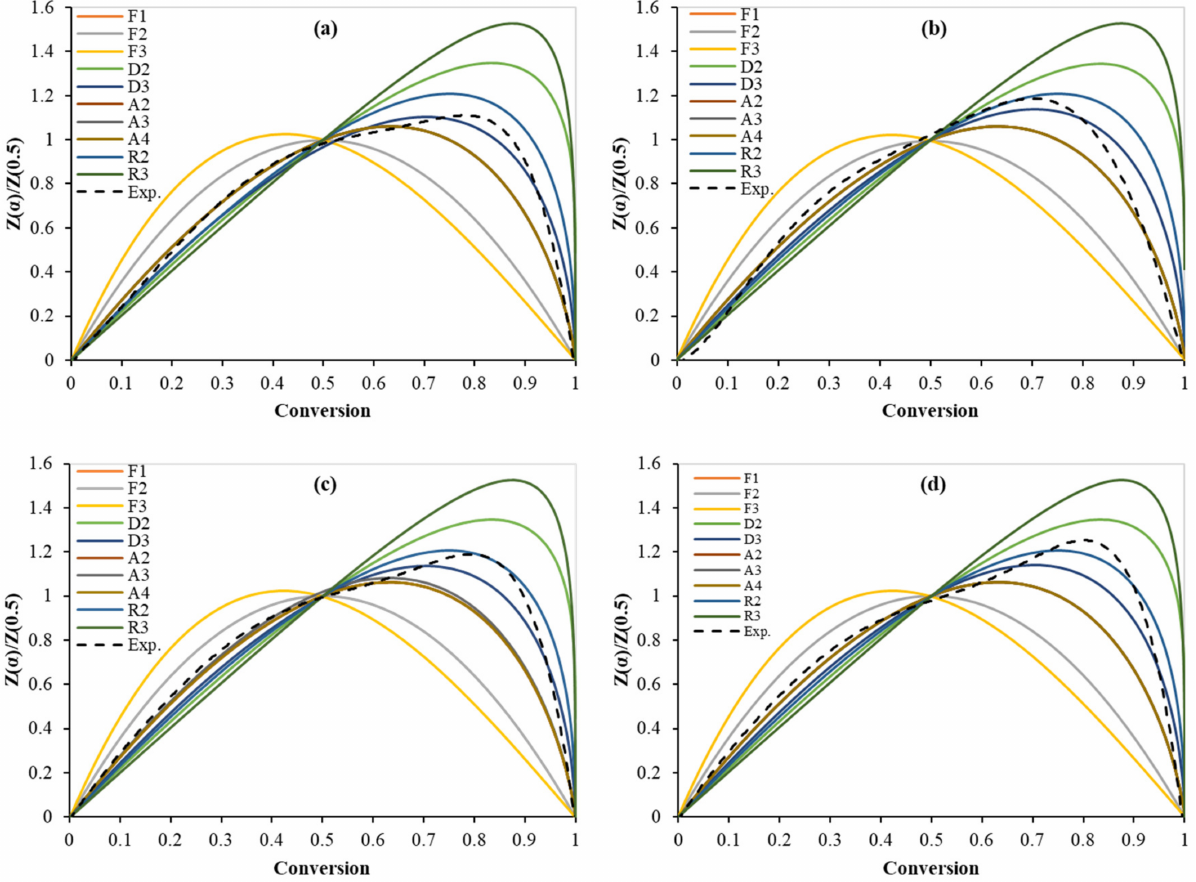
Figure 4. Criado model master plots of the PLA pyrolysis at different heating rates: ( a ) 5 K/min ( b ) 10 K/min, ( c ) 20 K/min, and ( d ) 30